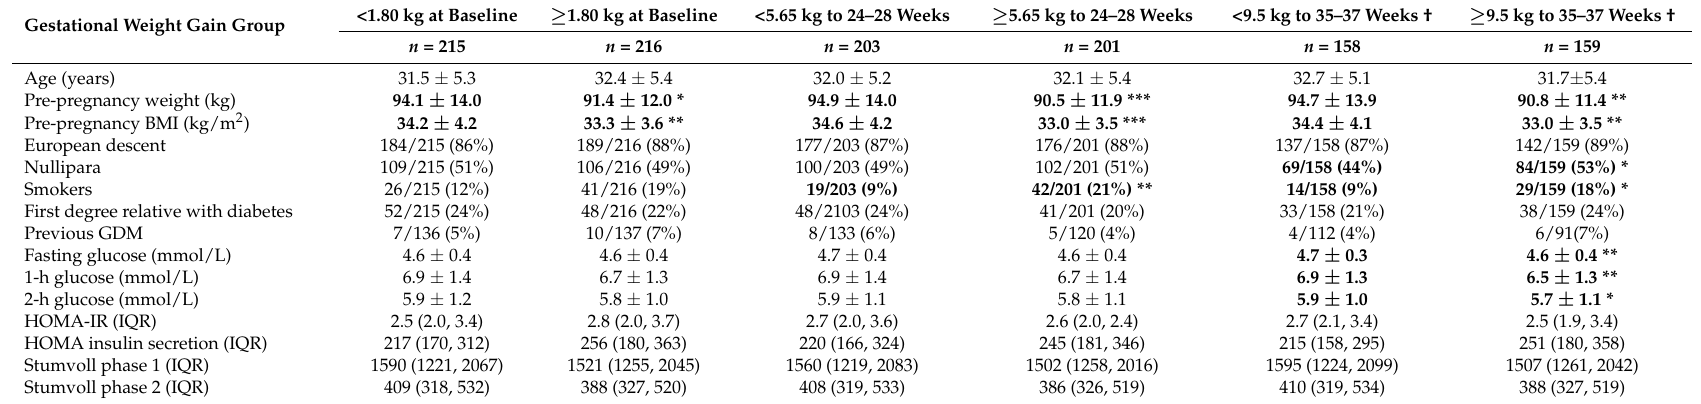
Table 1. Maternal baseline characteristics in the Vitamin D and Lifestyle Intervention for Gestational Diabetes Mellitus (GDM) Prevention (DALI) participants, above and below median gestational weight gain from pre-pregnancy to baseline, to 24–28 weeks, and to 35–37 weeks gestation. The latter excludes women with GDM at 24–28